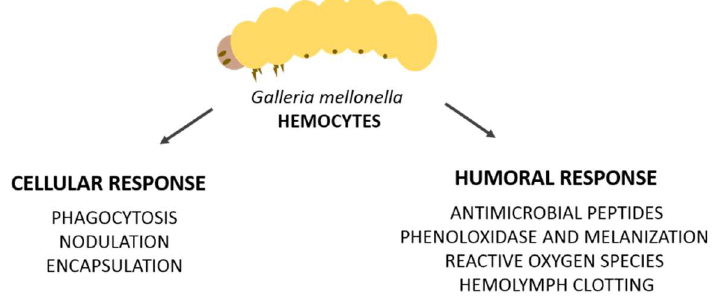
Figure 1. Schematic representation of G. mellonella immune response. Hemocyte activity links cellular and humoral responses.